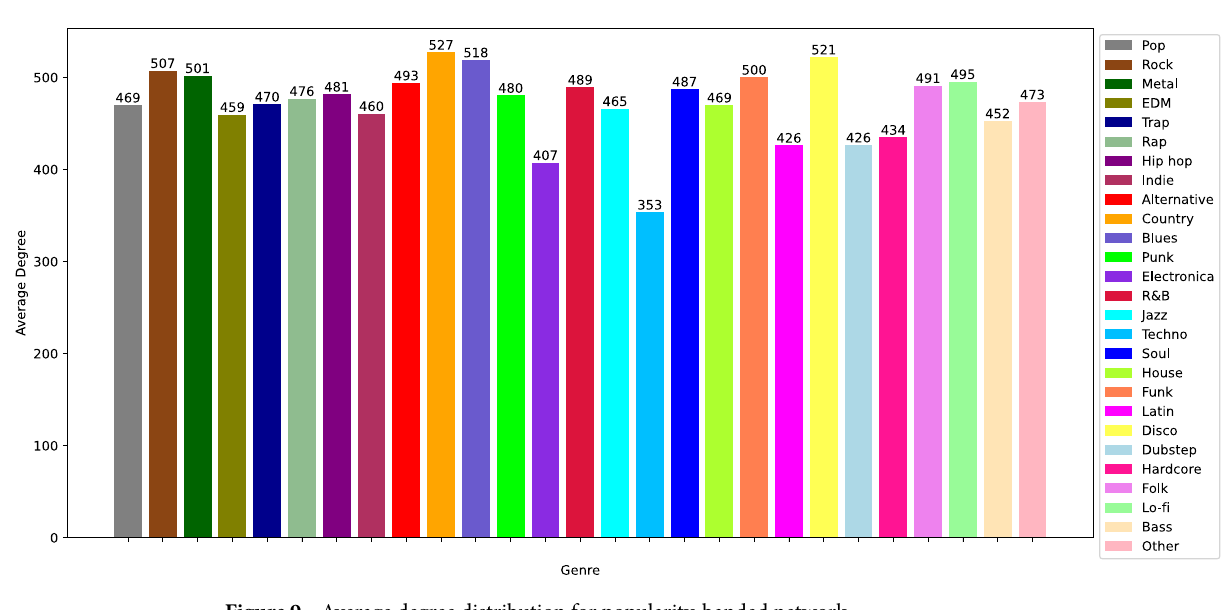
Figure 9. Average degree distribution for popularity-banded